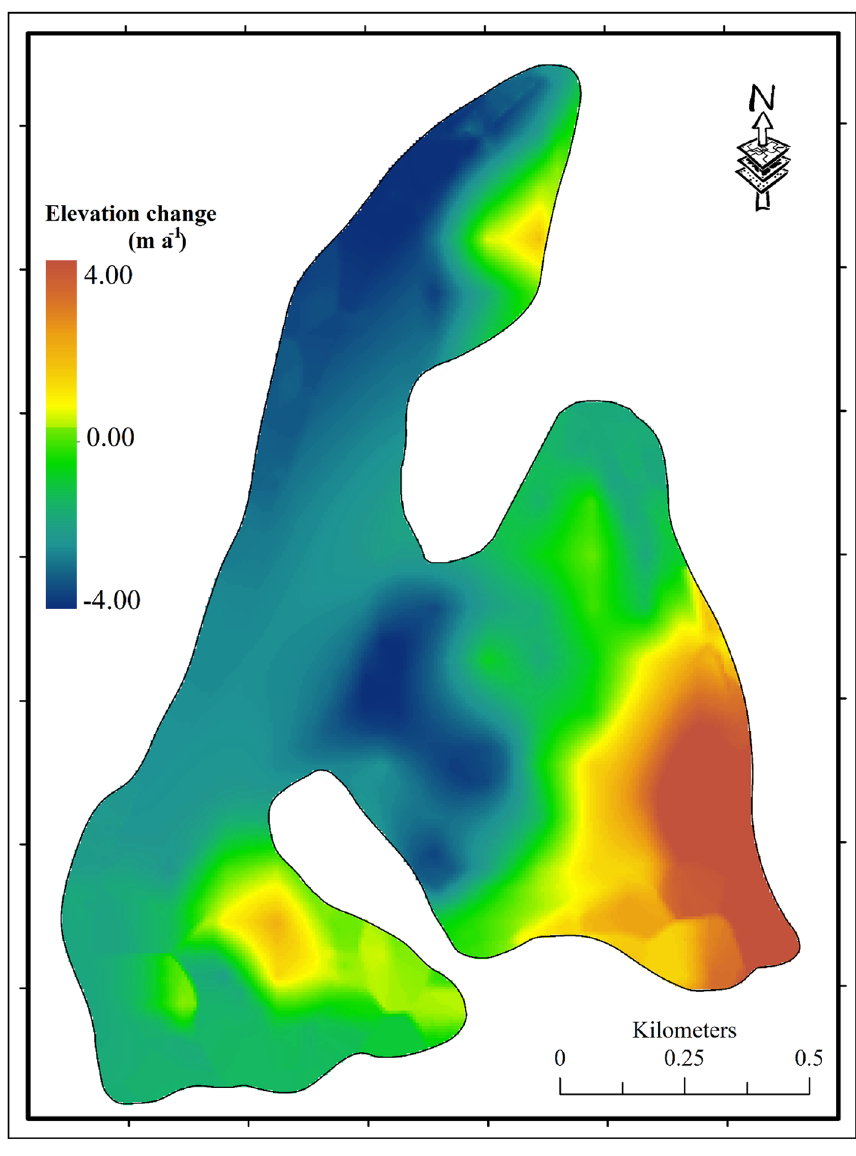
Figure 4. Interpolated elevation changes of the Hoksar Glacier from 2000 to